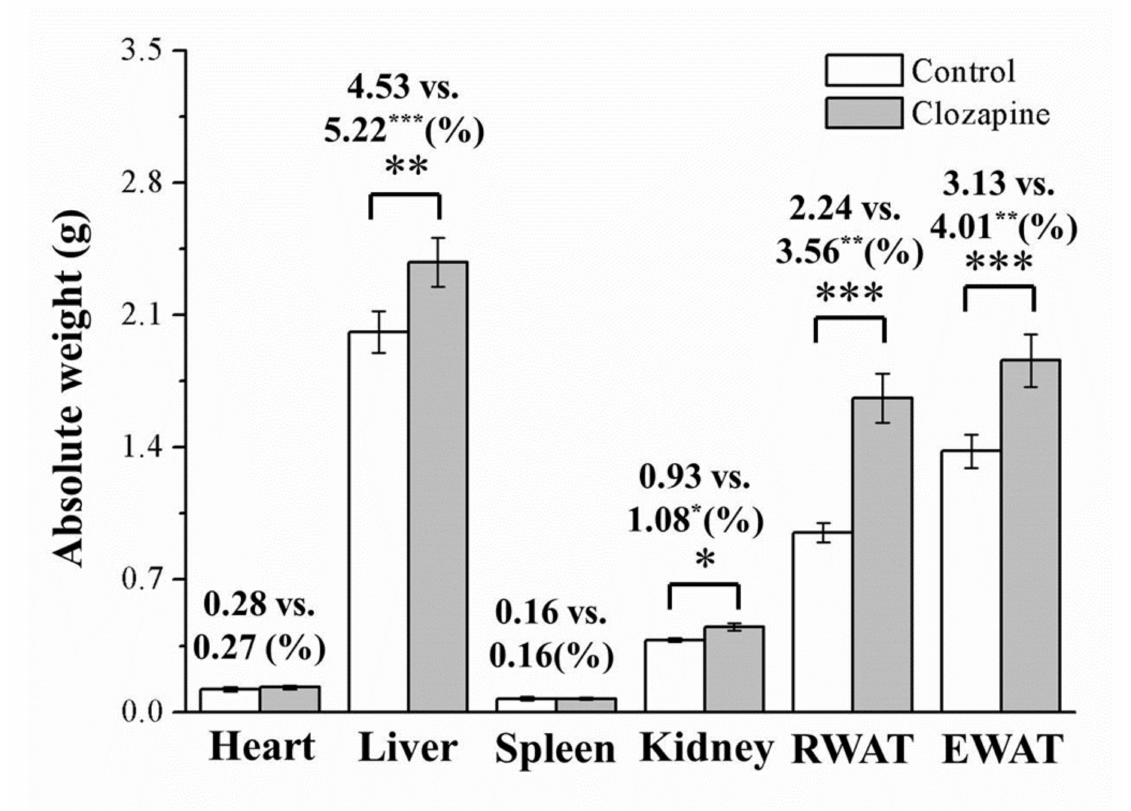
Figure 2. Mass of epididymal white adipose tissue (EWAT), retroperitoneal white adipose tissue (RWAT), and organs in clozapine (receiving 2 mg/kg/day) and control groups after 8-week experimental period. Numbers above bars indicate masses normalized by body weight. Data are mean ± standard deviation ( n = 10). * p < 0.05, ** p < 0.01, *** p <